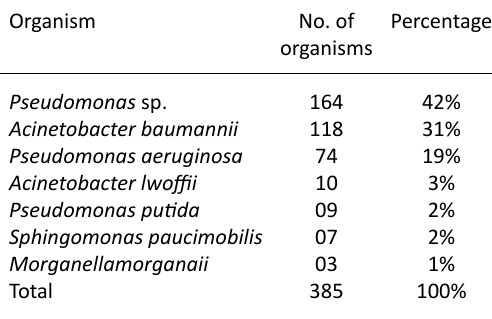
Table 3. Organism wise distribution of isolates (n=385) Organism No. of